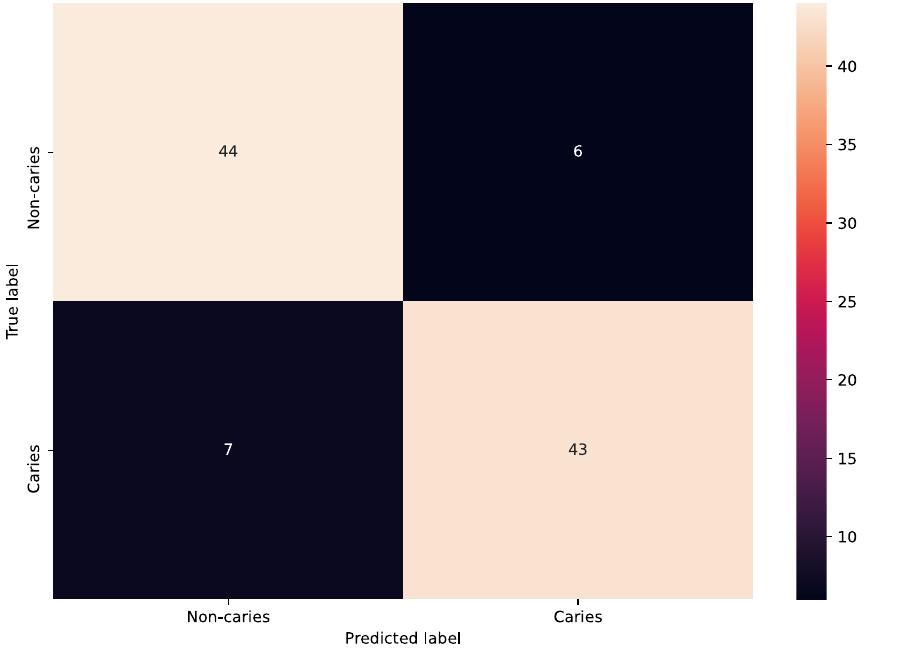
Figure 2. Confusion matrix showing the classification